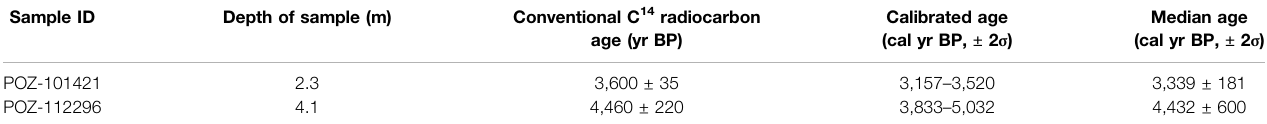
TABLE 2 | AMS 14 C ages and calibrated ages of the foraminifera from the BKR trench site, Kachchh. Sample ID